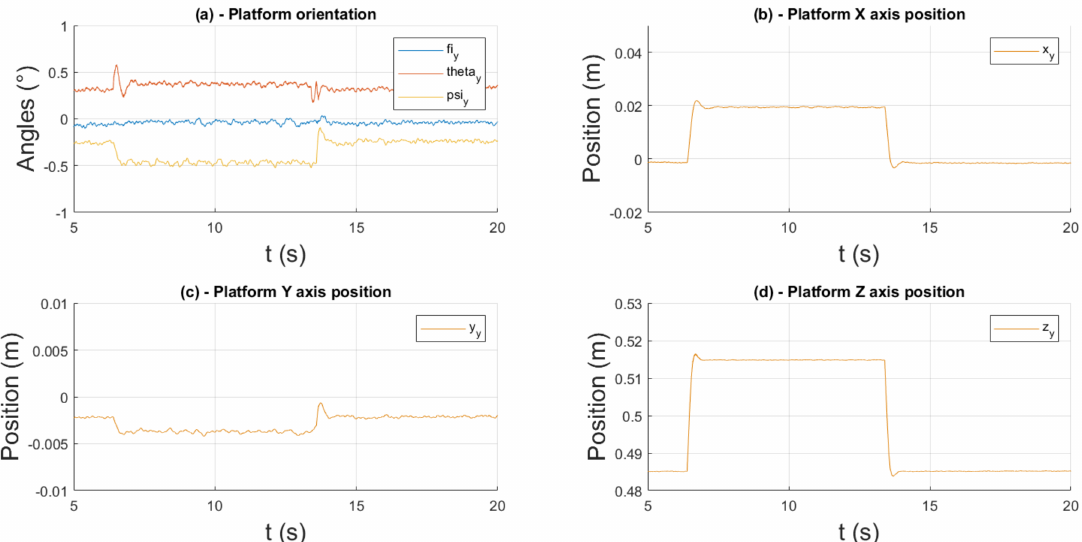
Figure 17. Moving plate position and orientation (HiL). ( a ) Actual ( ϕ y , θ y , Ψ y ) orientation of the moving plate; ( b ) Actual (x y ) positon of the moving plate in the X b axis; ( c ) Actual (y y ) position of the moving plate in the Y b axis; ( d ) Actual (z y ) position of the moving plate in the Z b axis.